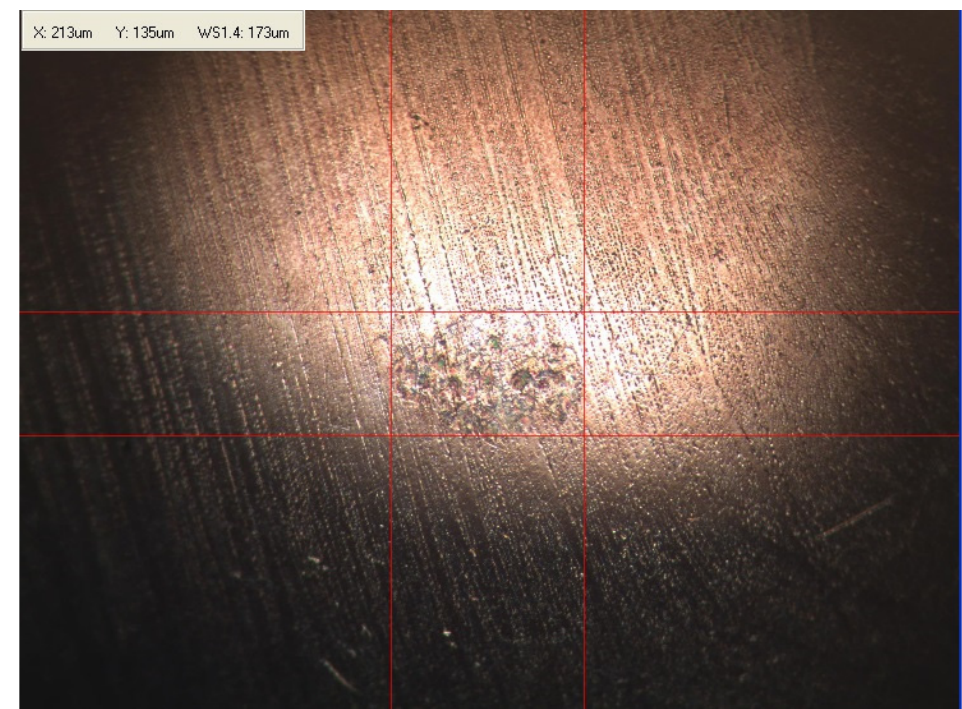
Figure A3. SAE 30—98% m/m; DO—2% m/m.